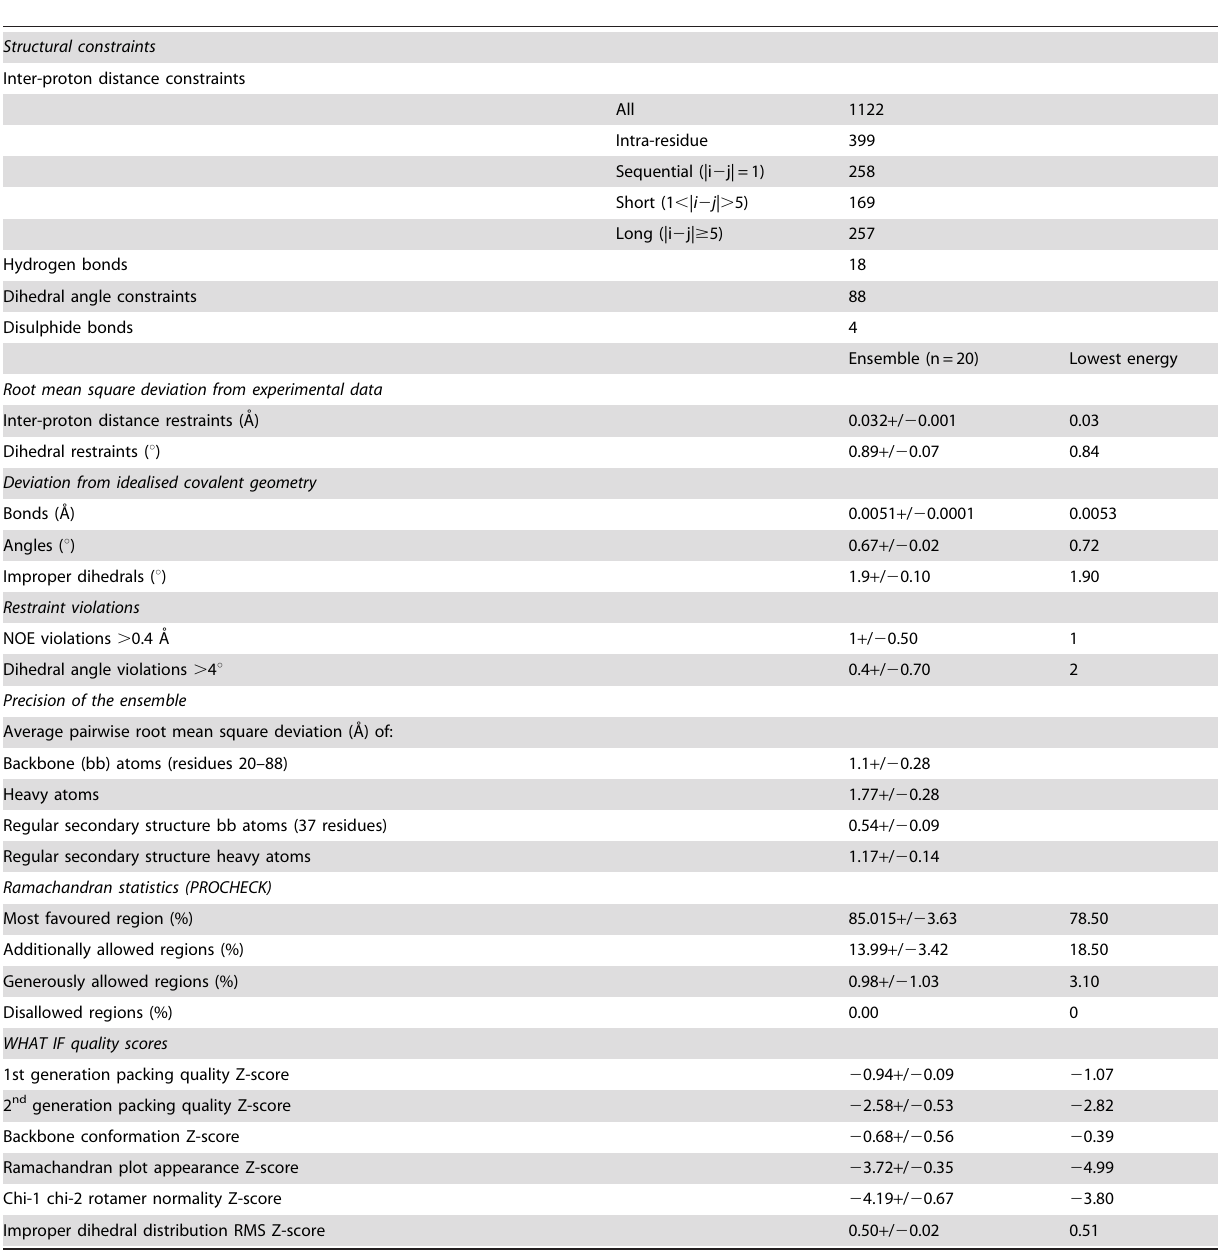
Table 1. Restraints and structural statistics of the Prod1